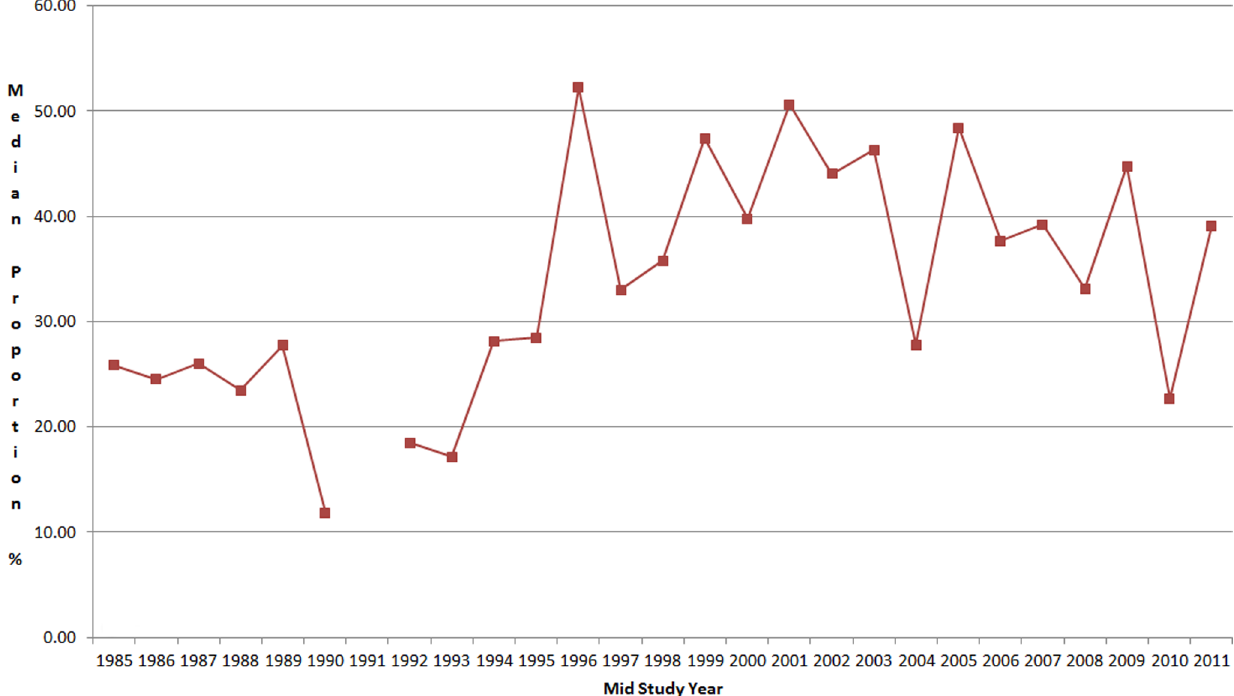
Figure 3. Median proportion of stool samples with rotavirus by mid study period. doi:10.1371/journal.pone.0072788.g003 PLOS ONE |